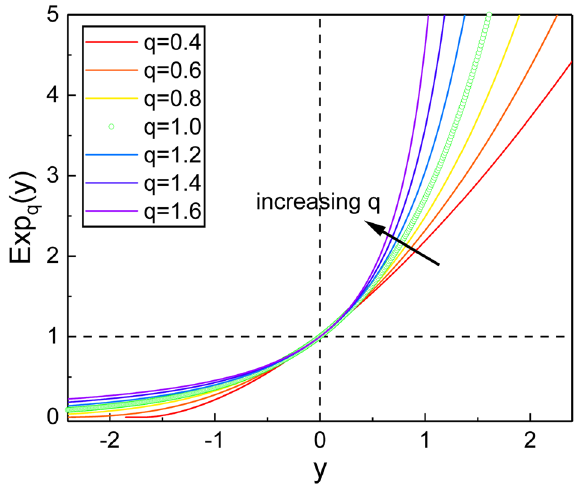
Figure 1. q-exponential function for several different values of q